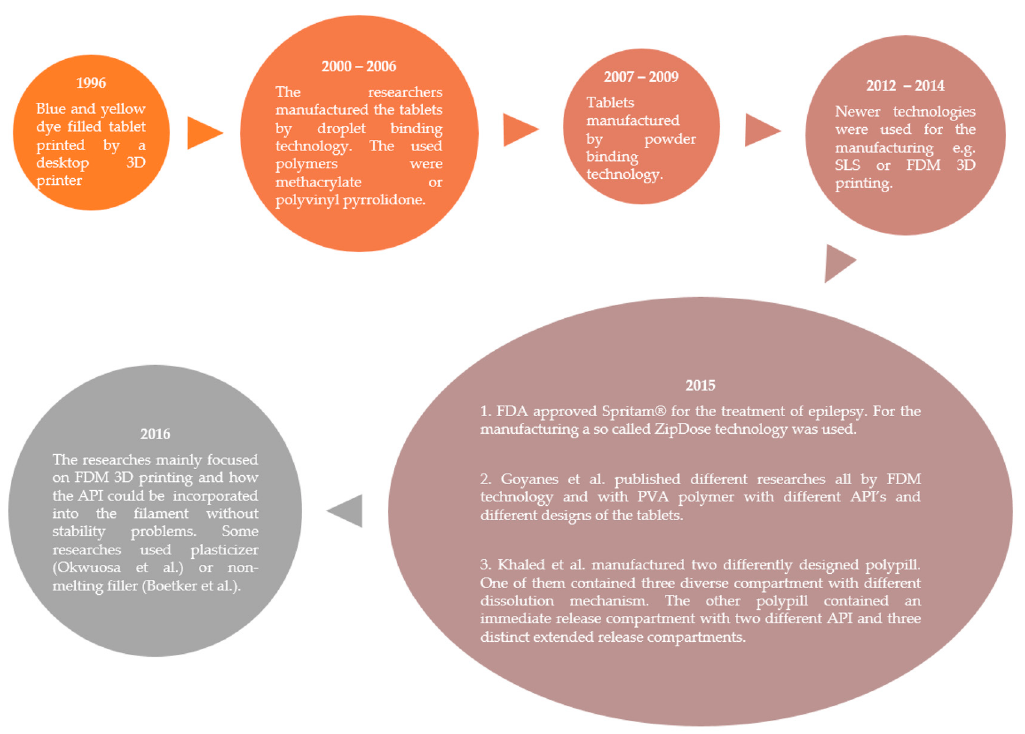
Figure 5. Flow chart on the described tablet manufacturing methods and main breakthroughs between 1996 and 2016